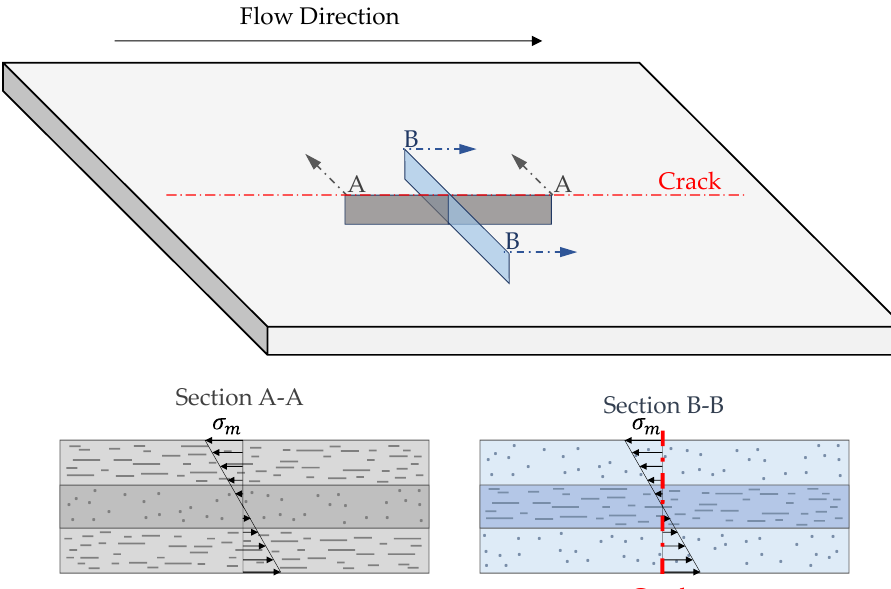
Figure 19. Anisotropic response of impact specimens.